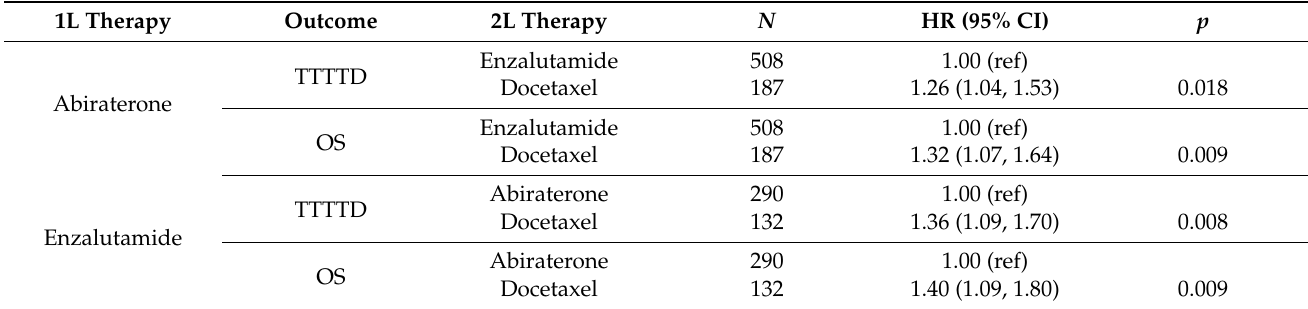
Table 2. Hazard ratios (HRs) and 95% confidence intervals (CIs) comparing survival outcomes on second-line (2L) docetaxel vs. 2L alternate NHT. The HRs are from Cox proportional hazards models weighted using matching weights from propensity scores to adjust for potential